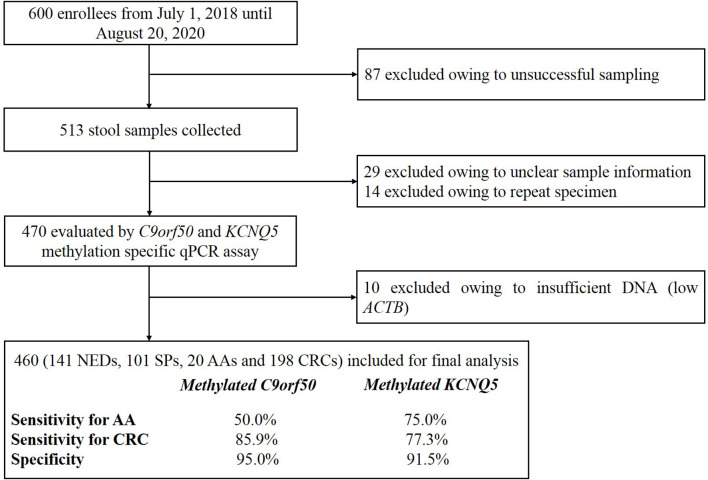
The flowchart of this study.